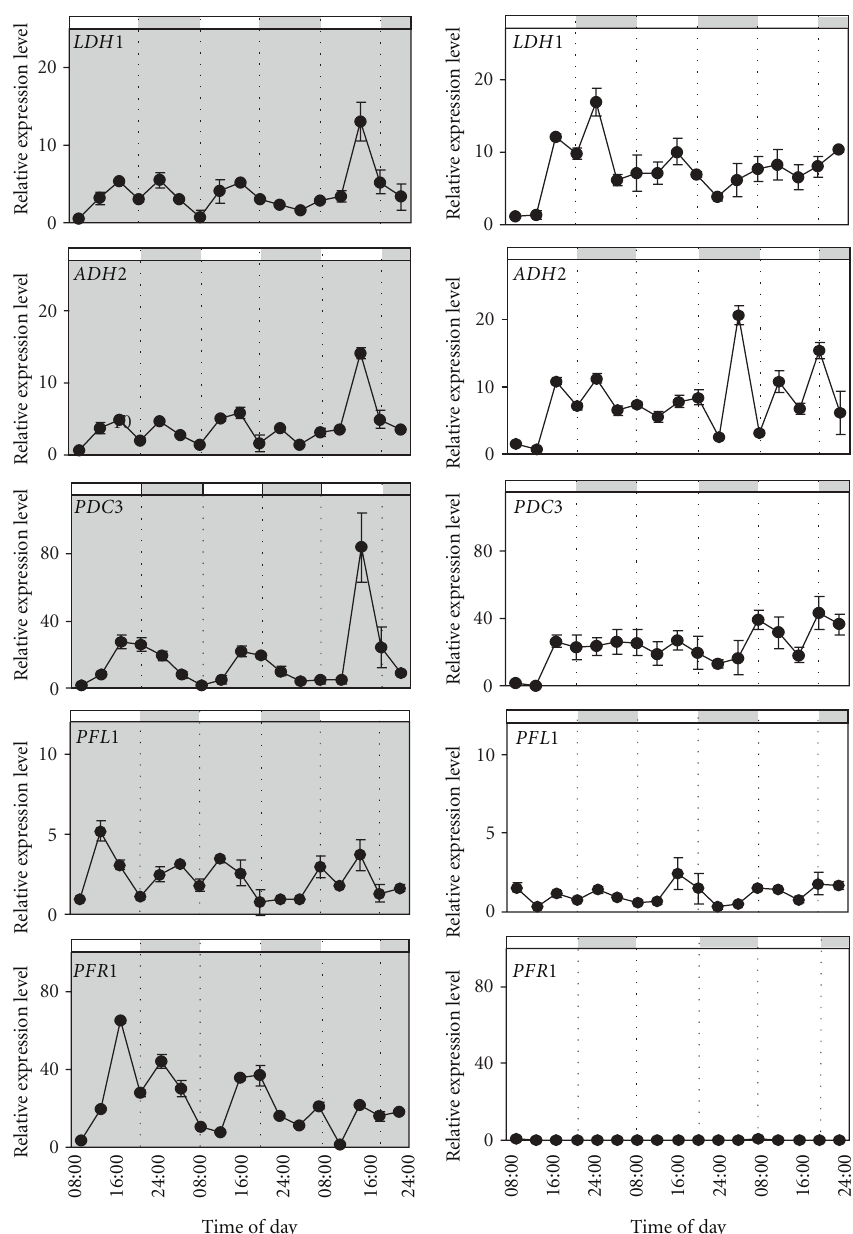
Figure 2: Expression patterns for LDH1, ADH2, PDC3, PFL1, and PFR1 in synchronized Chlamydomonas cells over 24-hour cycles are shown in continuous dark (left, shaded box) and continuous light (right, white box), with samples taken every 4 hours. Cells were grown at 23 ◦ C. The bar on top of each graph depicts the corresponding virtual day/night periods. Relative expression levels were measured by real-time reverse-transcription polymerase chain reaction (qPCR) (1 = the value of expression measured at the first data point which corresponds to 8:00 on the first day). Data are mean ± SD, n = 3 replicates. When not shown the error bars were smaller than the